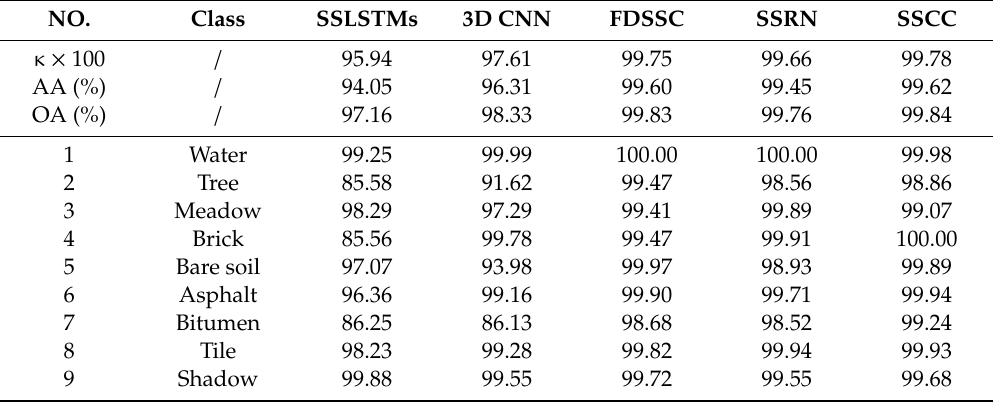
Table 4. Classification results of di ff erent methods for the Pavia Center